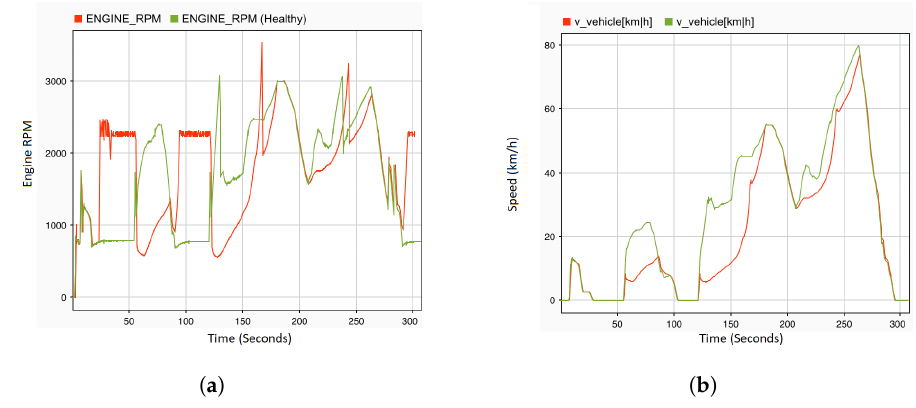
Figure 12. System output: engine RPM and vehicle speed under multiple permanent faults injection. ( a ) Engine RPM with stuck-at fault and noise fault. ( b ) Vehicle speed with stuck-at fault and noise